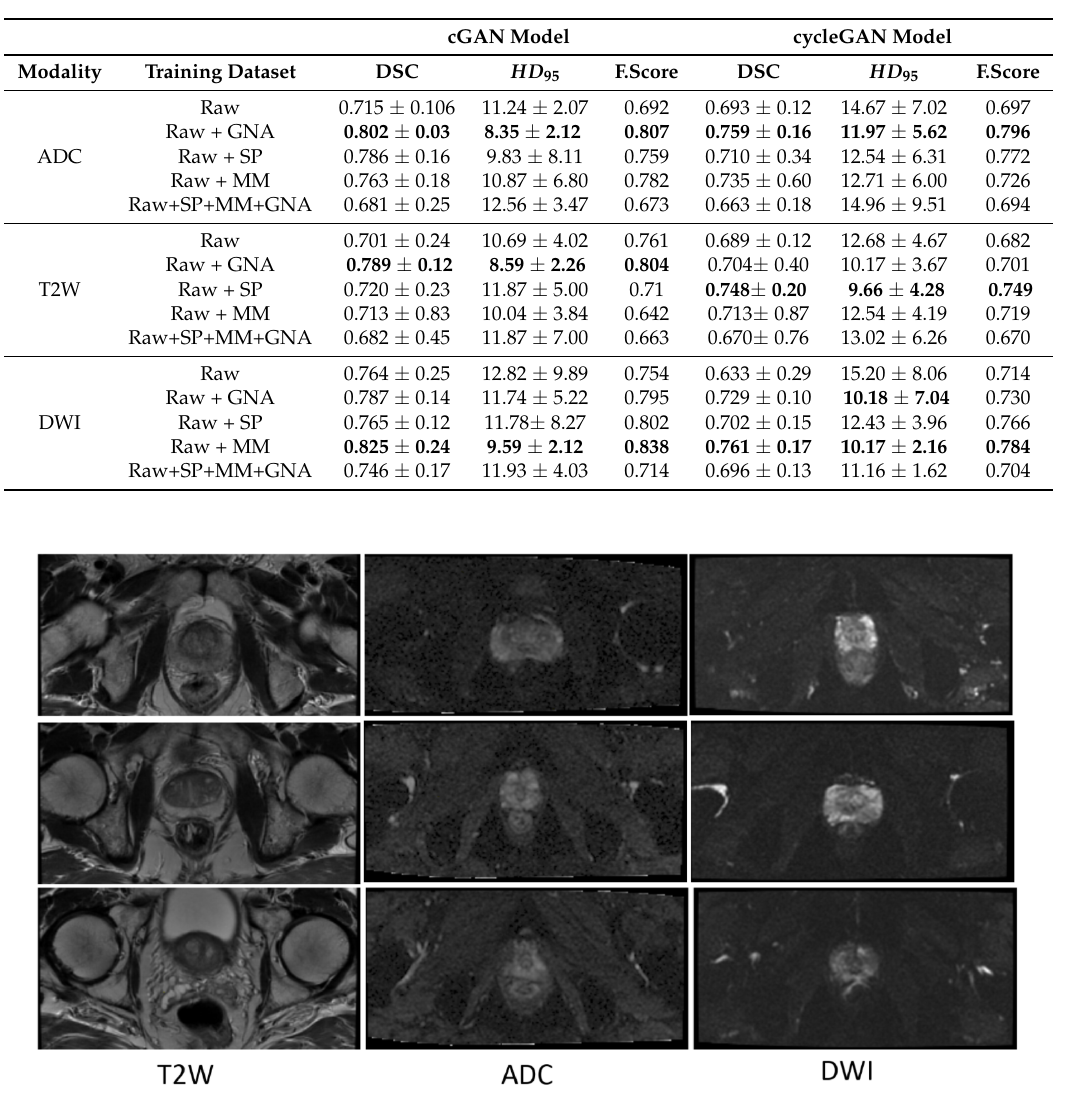
Table 1. Quantitative results of the segmentation/detection for each modality using cGAN and cycleGAN models.